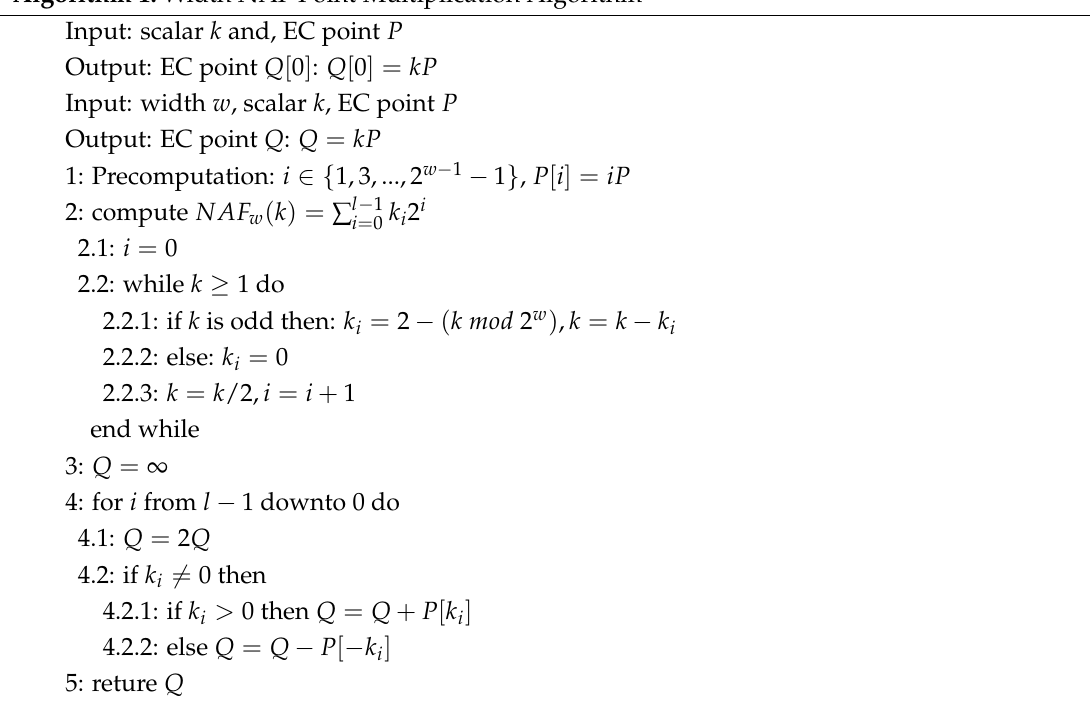
Algorithm 1: Width NAF Point Multiplication